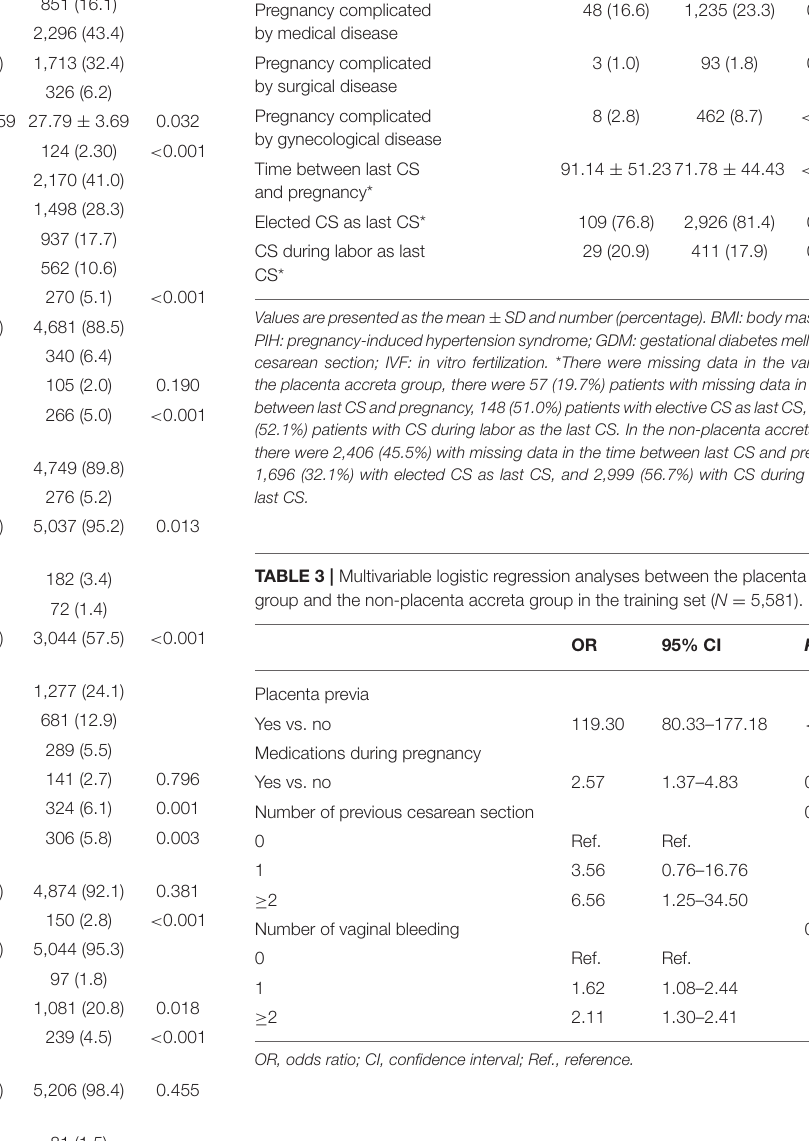
regression analyses are shown in Table 3 . In the PA group, there were 57 (19.7%) patients with missing data in the time between last CS and pregnancy, 148 (51.0%) patients with elective CS as last CS, and 151 (52.1%) patients with CS during labor as the last CS. In the non-PA group, there were 2,406 (45.5%) with missing data in the time between last CS and pregnancy, 1,696 (32.1%) with elected CS as last CS, and 2,999 (56.7%) with CS during labor as last CS. In univariable analyses, in the presented data, the times between last CS, CS during labor as last CS and elective CS as last CS were analyzed, with the missing